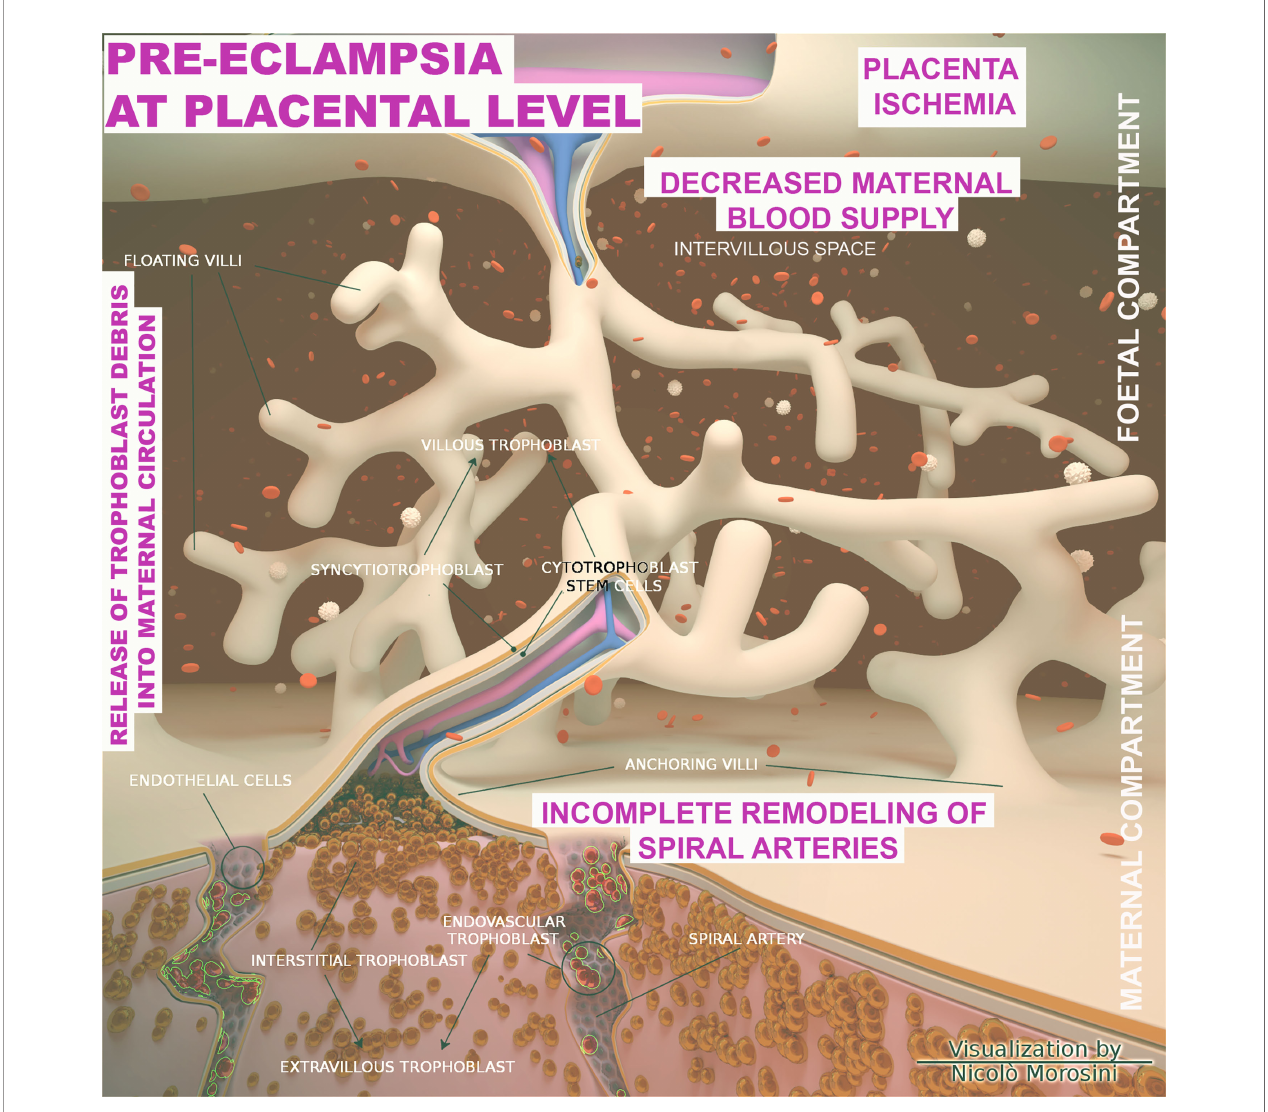
FIGURE 6 | Schematic representation of the placenta architecture in pre-eclampsia (PE). Overview of the structural organization of the placenta and feto/maternal interface during the abnormal placentation in PE. The diagram was designed using the Blender 3D (Blender Foundation, Stichting Blender Foundation, Buikslotermeerplein, Amsterdam, the Netherlands). Edited with permission from Balduit et al.